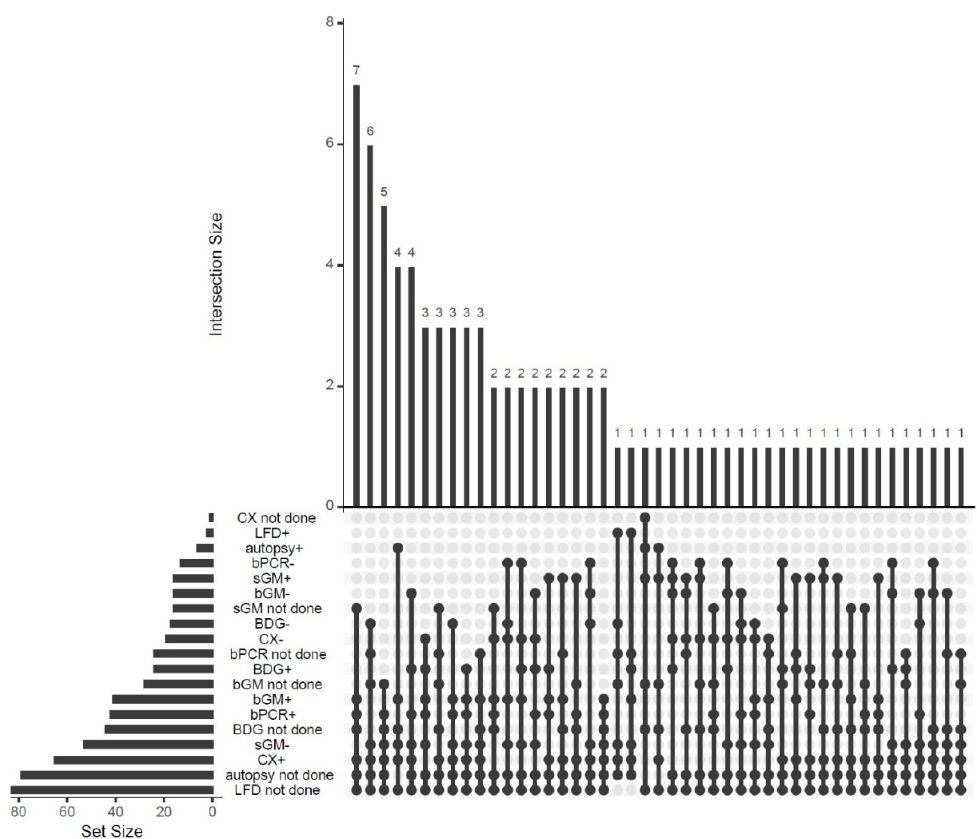
Figure 2. UpSet diagram of diagnostic modalities for the diagnosis of CAPA.